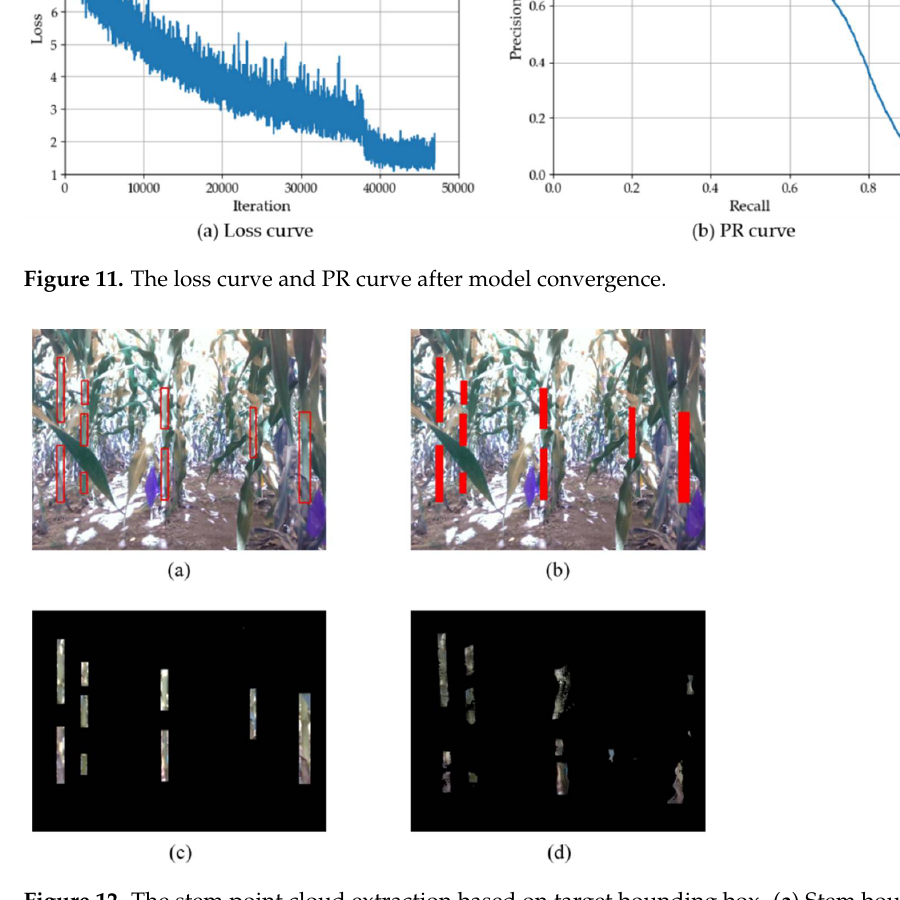
Figure 12. The stem point cloud extraction based on target bounding box. ( a ) Stem bounding box; ( b ) mask processing; ( c ) ROI of stem pixels; ( d ) stem point clouds.